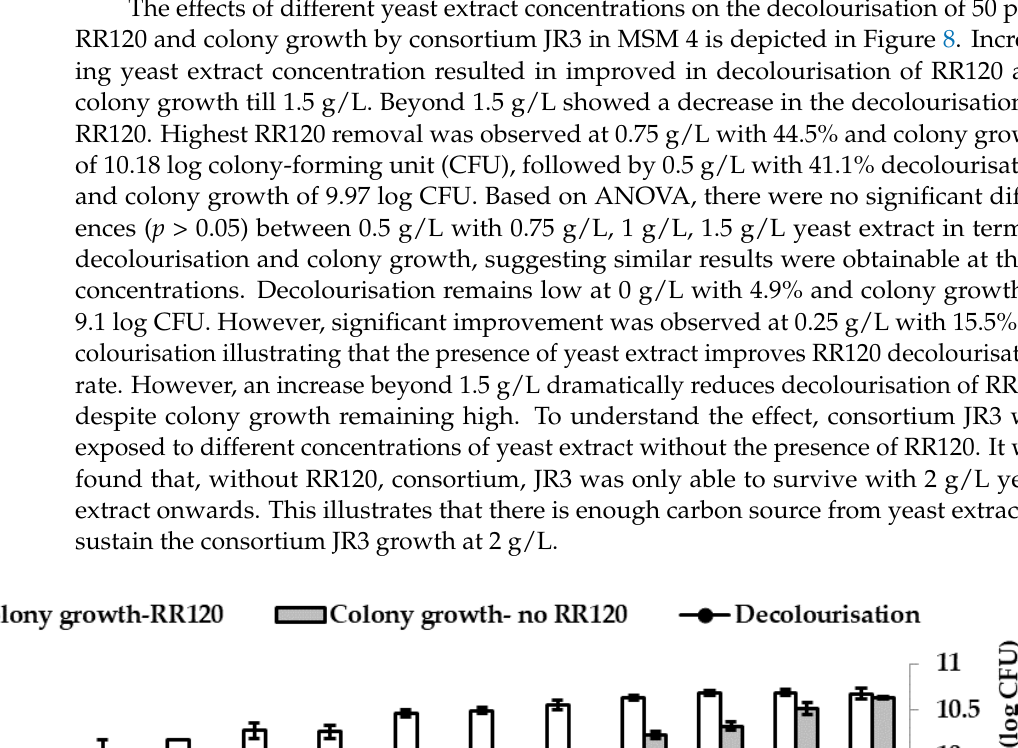
Figure 7. Effect of glucose and yeast extract in the media composition on the decolourisation of 50 ppm Reactive Red 120 by consortium JR3 at 24 h. Data represent mean ± SD, n = 3.